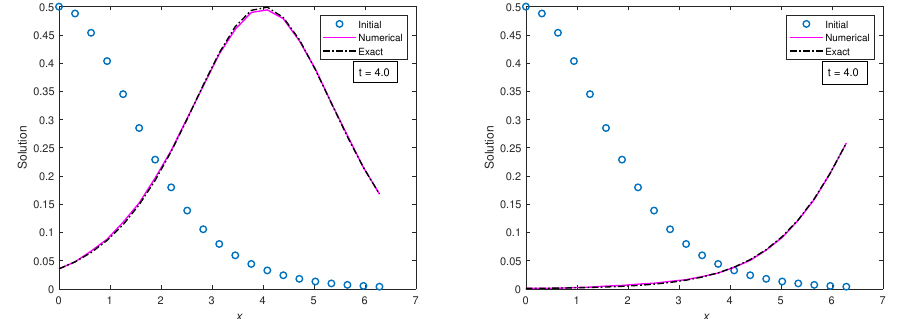
Figure 21. Plots of initial, numerical and exact solutions vs. x ∈ [ 0,2 π ] at times t = 0.10, 2.0, 4.0, 8.0, using the classical finite difference scheme with ∆ t = 10 − 2 and ∆ x =